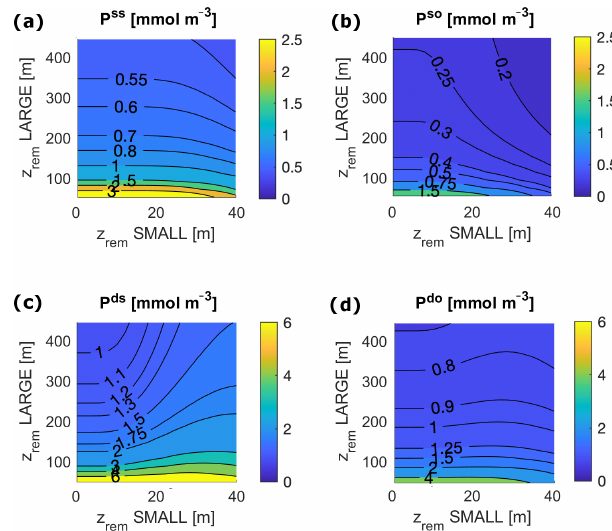
Figure 5. Local P concentration in each ocean box for varying z remS and z remL for the following: (a) surface shelf sea, ss; (b) surface open ocean, so; (c) deep shelf sea, ds; and (d) deep open ocean, do. Surface ocean boxes, as well as deep ocean boxes, are plotted on the same